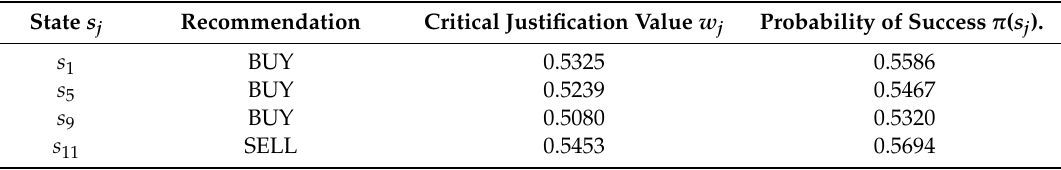
Table 5. Strategy given by ST ( XAU/USD,0.525,30,1.5, E 4 , Ξ 2 , Ψ 2 )